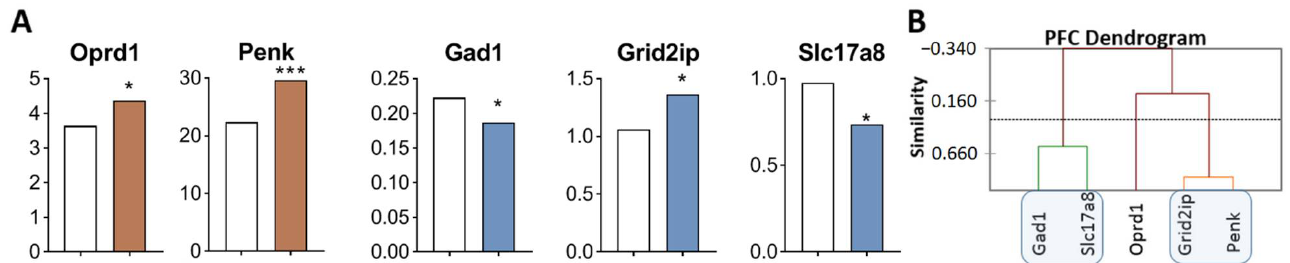
Figure 4. DEGs in the PFC of highly aggressive mice. ( A ) FPKM of opioidergic and glutamatergic DEGs in the PFC of mice. White bars—controls; colored bars—winners: brown—opioidergic genes; violet—glutamatergic genes (Supplementary Table S1). * p < 0.05; *** p < 0.001. ( B ) AHC based on five reference DEGs’ expression profiles (Supplementary Table S2). Similarity: Pearson’s correlation coef- ficient. Agglomeration method: Unweighted pair-group average. The main clusters are highlighted with a blue rounded